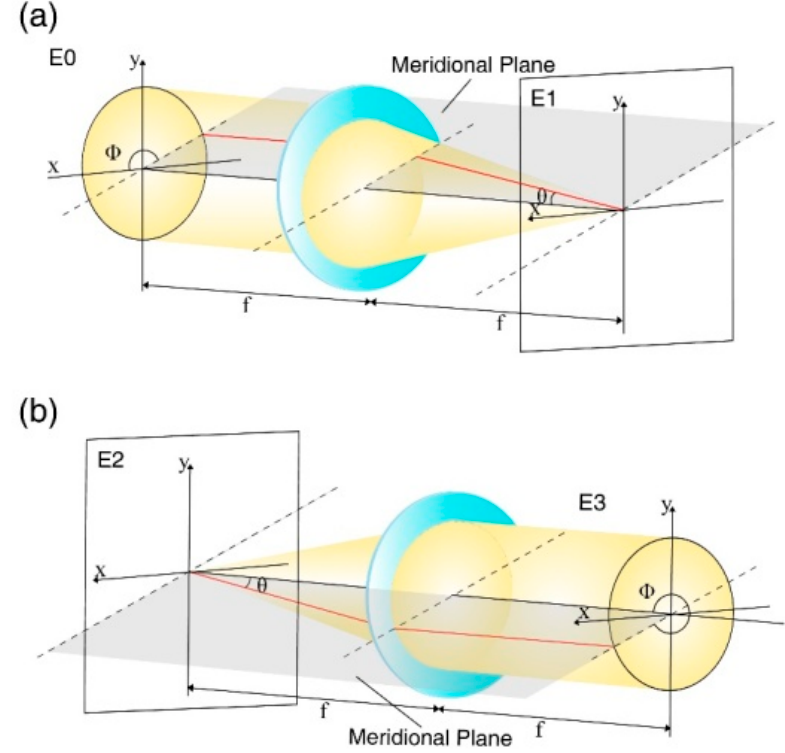
Figure 1. Schematics of light-beam propagation through a lens. ( a ) Focusing and ( b ) collection of light in a high-NA lens